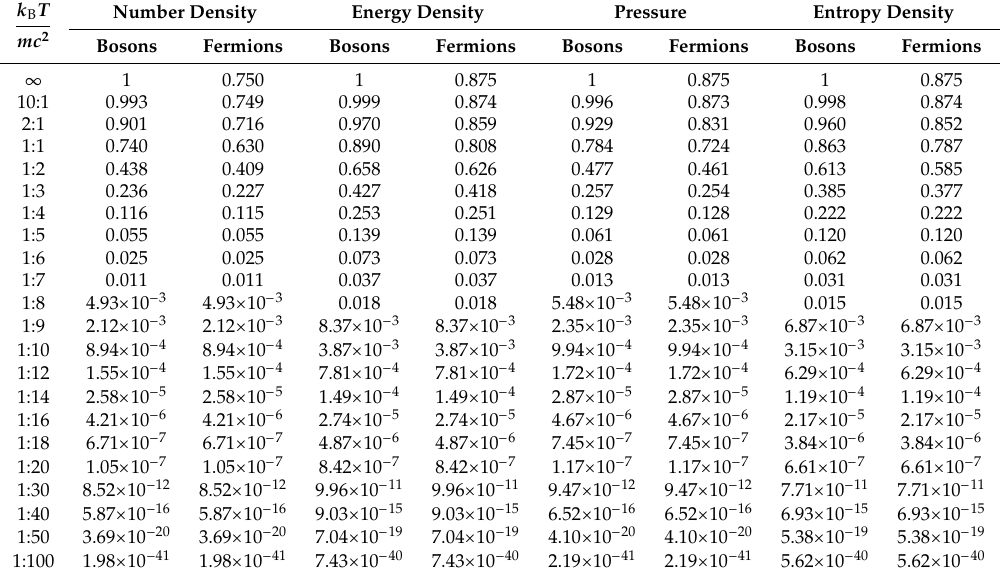
Table B1. The effective contribution to a single degree of freedom as function of temperature ( k B T ) over mass ( mc 2 )